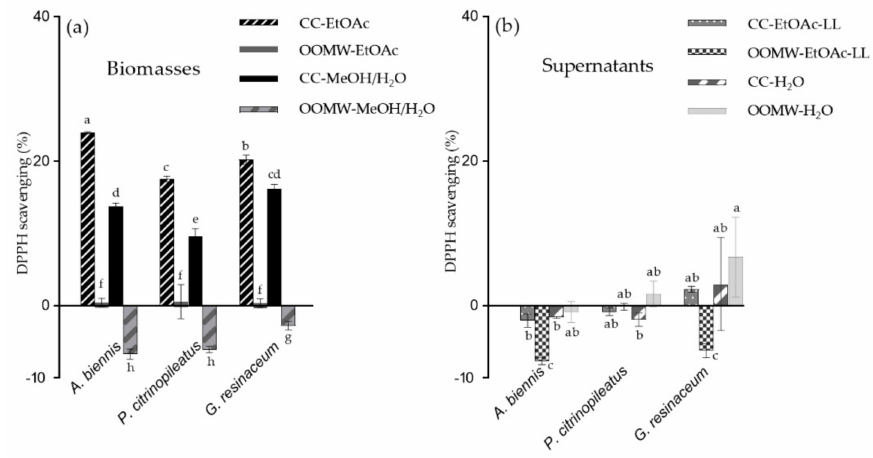
Figure 2. Antioxidant evaluation of fungal cultures (200 µ g mL − 1 ); ( a ) Biomasses; ( b ) Culture super- natants; Positive control: Gallic Acid (5 µ g/mL), inhibition% = 46.33 ± 1.51; DPPH scavenging activity of non-inoculated growth media: CC-EtOAc-LL= 34.66 ± 4.96, OMWW-EtOAc-LL = 18.64 ± 0.58, CC-H 2 O = 1.06 ± 0.83, OMWW- H 2 O = 0.42 ± 0.47. Experiments were performed in triplicate; Error bars indicate ± standard errors; ( p < 0.001, HSD Tukey